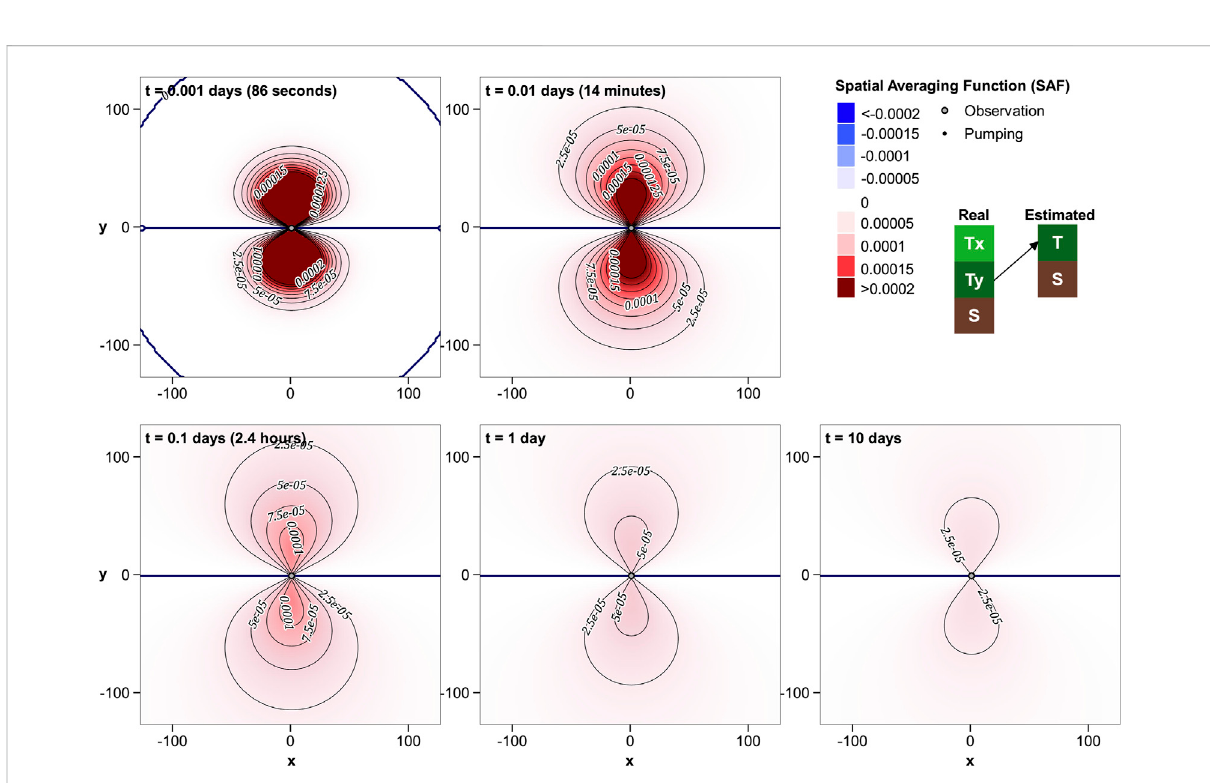
FIGURE 13 R ′ T − Ty for near-coincident wells at fi ve different